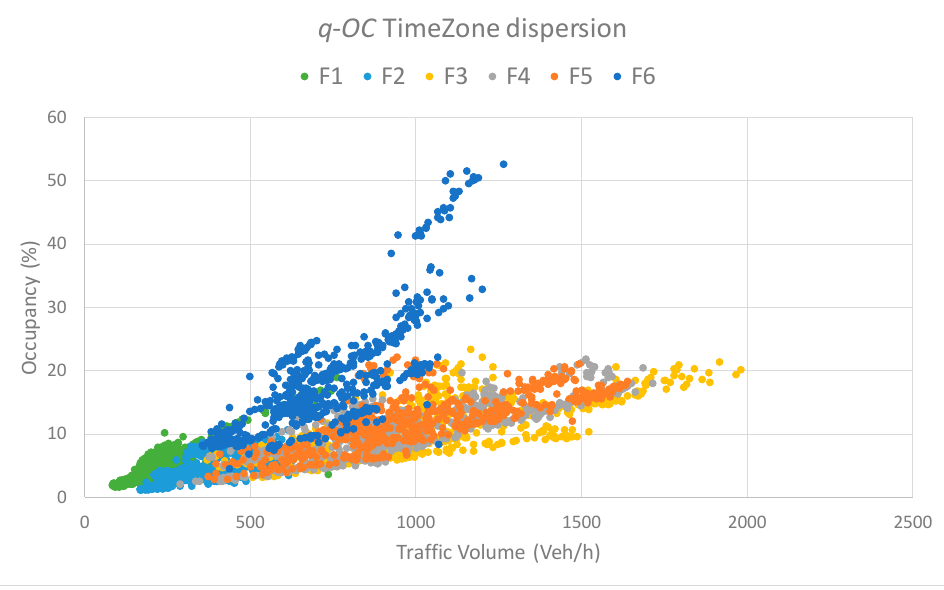
Figure 9. Time zone-based traffic volume and occupancy dispersion in June 2019.